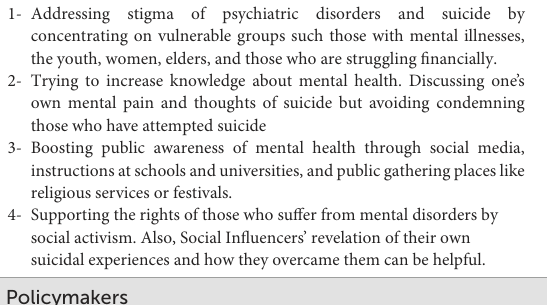
TABLE 1 Recommendations to reduce the stigma toward suicide and encouraging utilizing suicide prevention system. Public level